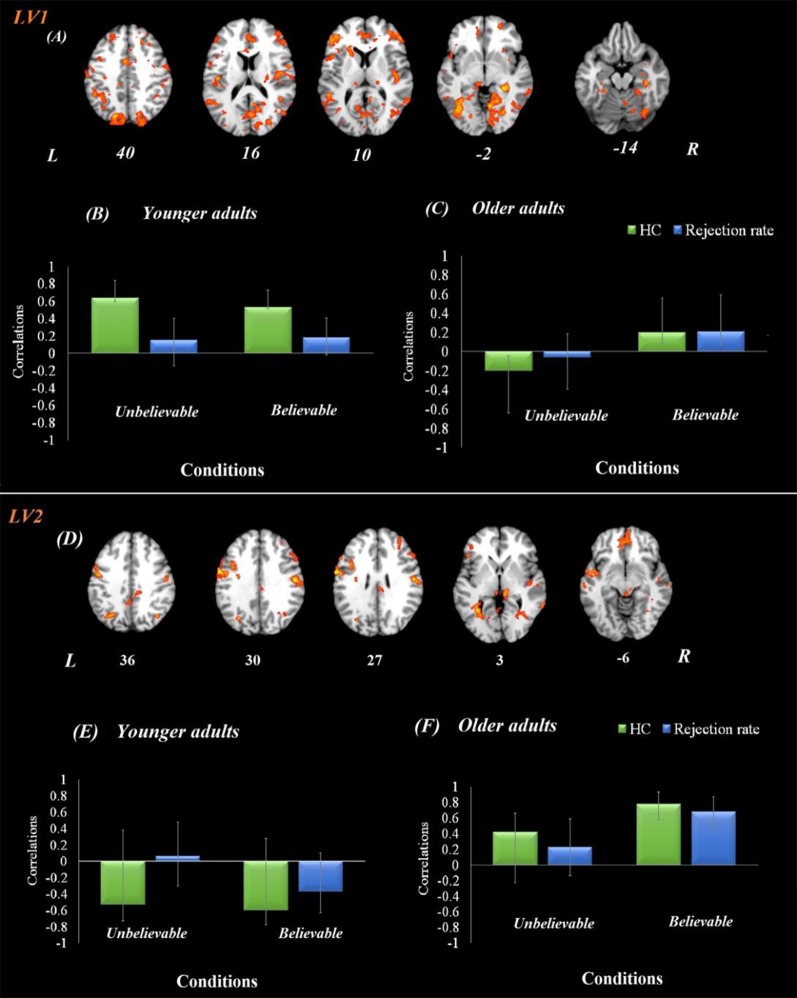
Hippocampal functional connectivity results in both age groups. Onsets of the premise stage were used for this analysis using seed-behavioral PLS. LV1 represents the functional connectivity of hippocampal activity in the first latent variable. (A) The functional network connected to the hippocampus during the premise integration stage. Panels (B,C) show correlations between activity in the hippocampal brain network and behavioral performance among younger and older adults, respectively, for each experimental condition. LV2 represents the functional connectivity of hippocampal activity in the second latent variable, demonstrating a compensatory network. Panel (D) demonstrates the functional network connected to the hippocampus during the premise integration stage. Panels (E,F) show correlations between activity in the hippocampal brain network and behavioral performance among younger and older adults, respectively, for each experimental condition. For visualization purposes, bootstrap ratio threshold is set at 2.5 (p < 0.005); however, reported whole-brain activity is set at BSR 3 (p < 0.001). Error bars represent 95% confidence intervals when crossing zero interprets as unreliable. Abbreviations: LV, latent variable; HC, hippocampus, L, left hemisphere, R = right hemisphere.